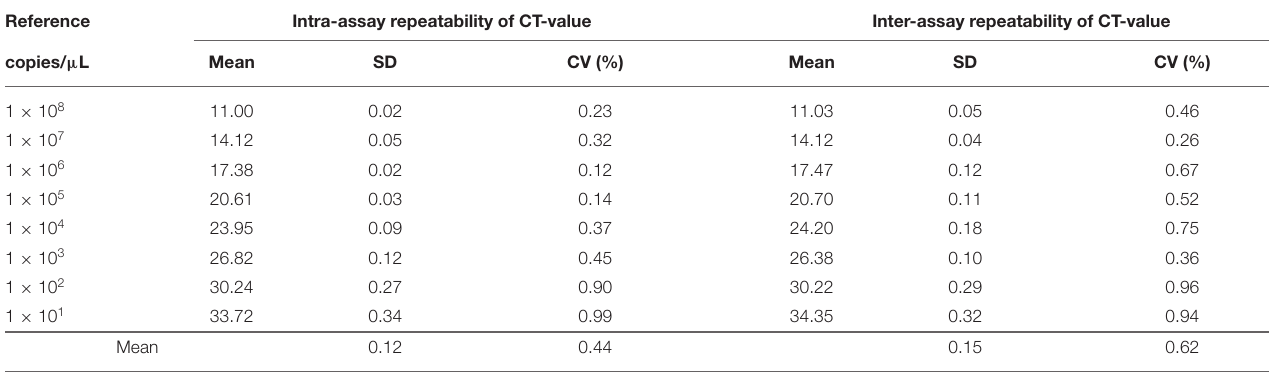
TABLE 1 | The repeatability of A137R gene-based real-time PCR. Reference